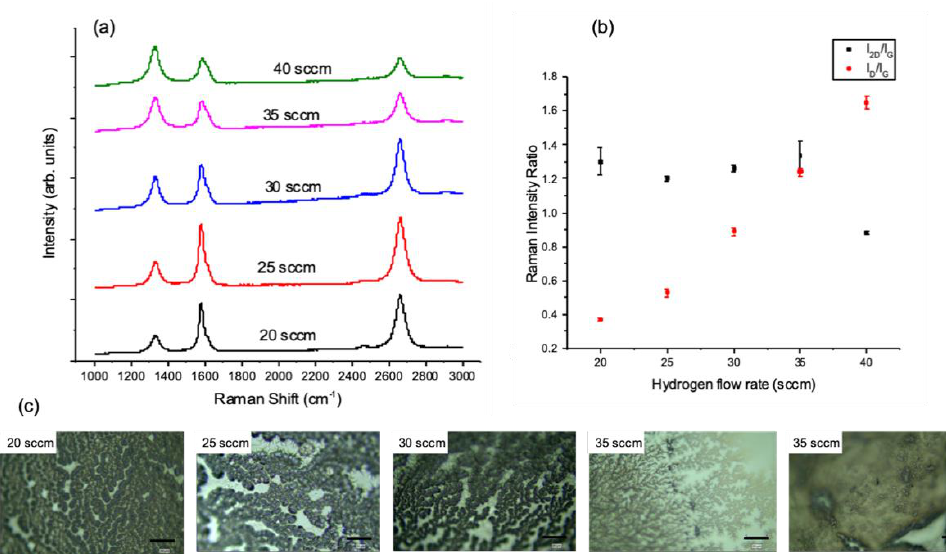
Figure 2. ( a ) Raman spectra of the graphene grown on liquid In, showing the effect of changing the H 2 flow rate. ( b ) Average Raman intensity ratio of the I 2D /I G and I D /I G values vs. the H 2 flow rate based on map data (error bars are smaller than some of the data points). ( c ) Optical images of the as- grown graphene films (scale bar: 20 µm), some blurriness is due to the surface curvature of the solidified In (APCVD, T = 1120 C, (20 – 40) H 2 / 500 Ar / 5 CH 4 sccm, t = 5 min).